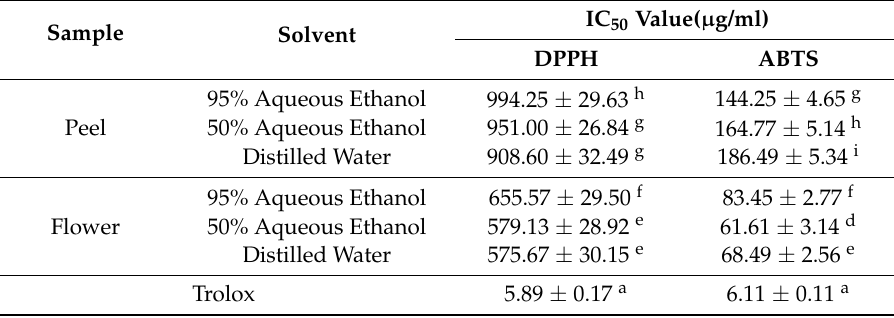
Table 4. The percentage of cell survival for crude extracts from Hylocereus polyrhizus parts as detected using the 3-(4,5-Dimethylthiazol-2-yl)-2,5-diphenyltetrazolium bromide (MTT) cell proliferation assay.